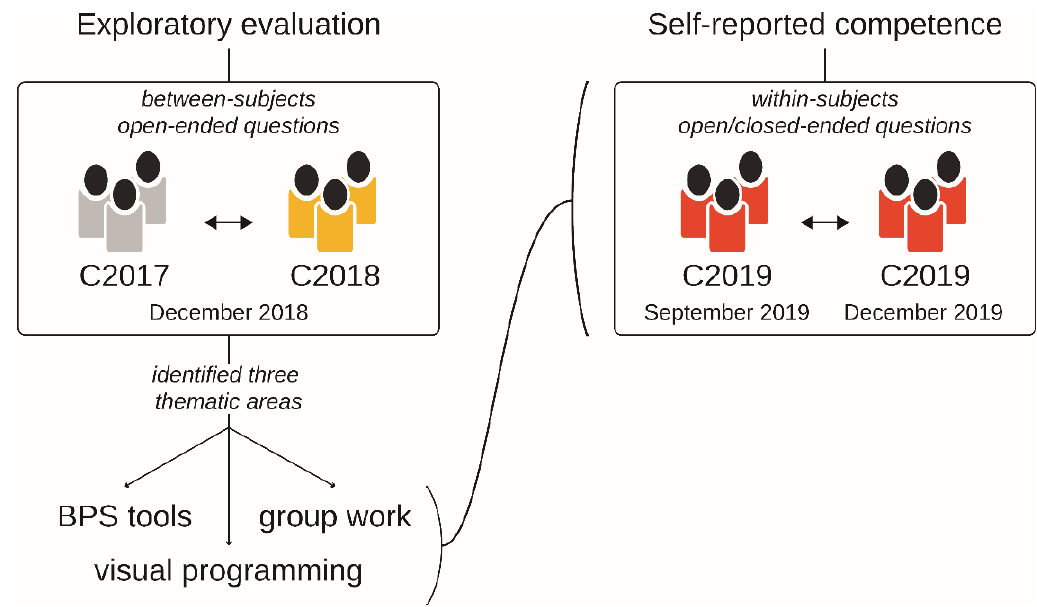
Figure 6. The two evaluations of the control method.